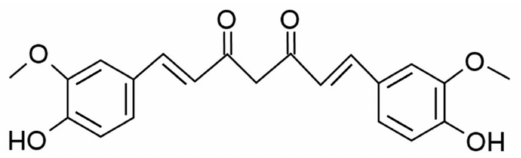
Figure 5. Chemical structure of curcumin.